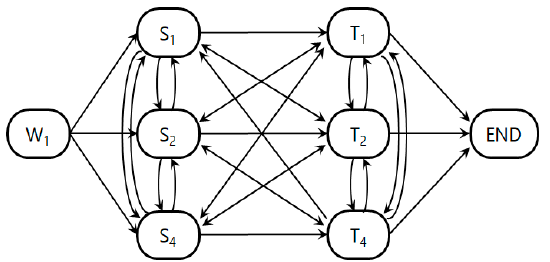
Figure 2. An example of a state-transition diagram for 3 jobs by a worker.